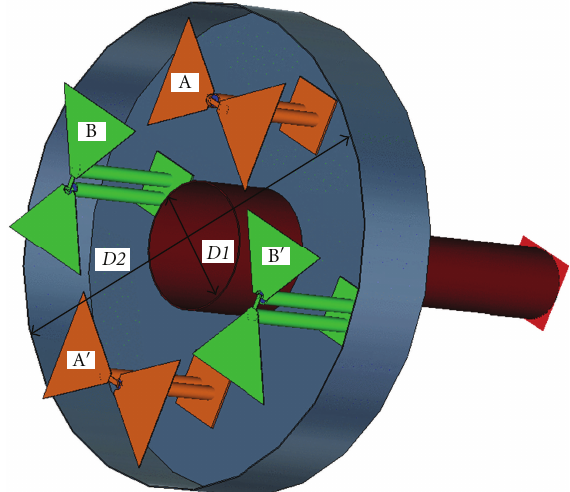
Figure 3: Layout of the dual-band feed, overall view.